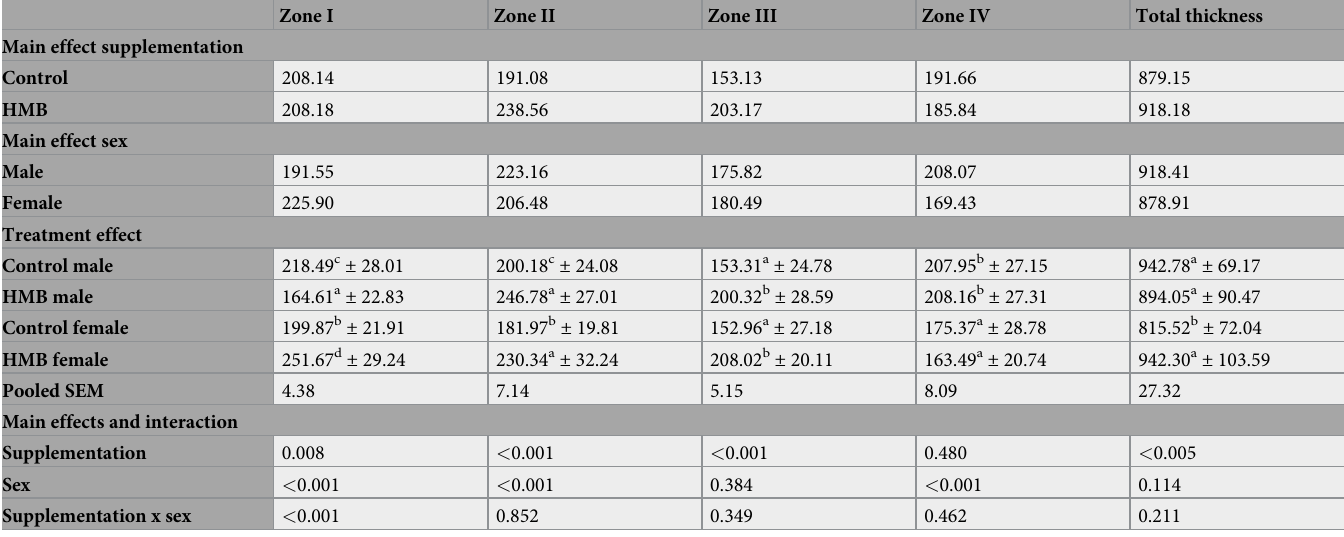
Table 5. The effect of maternal treatment with HMB on humerus growth plate cartilage histomorphology in newborn